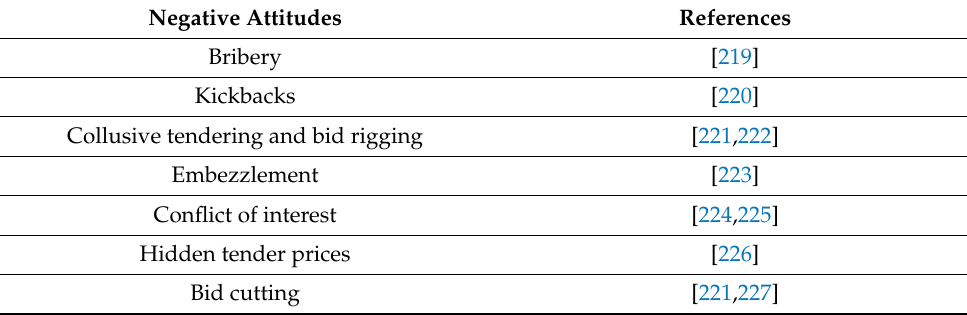
Table 6. Negative attitude towards DTs in the AEC